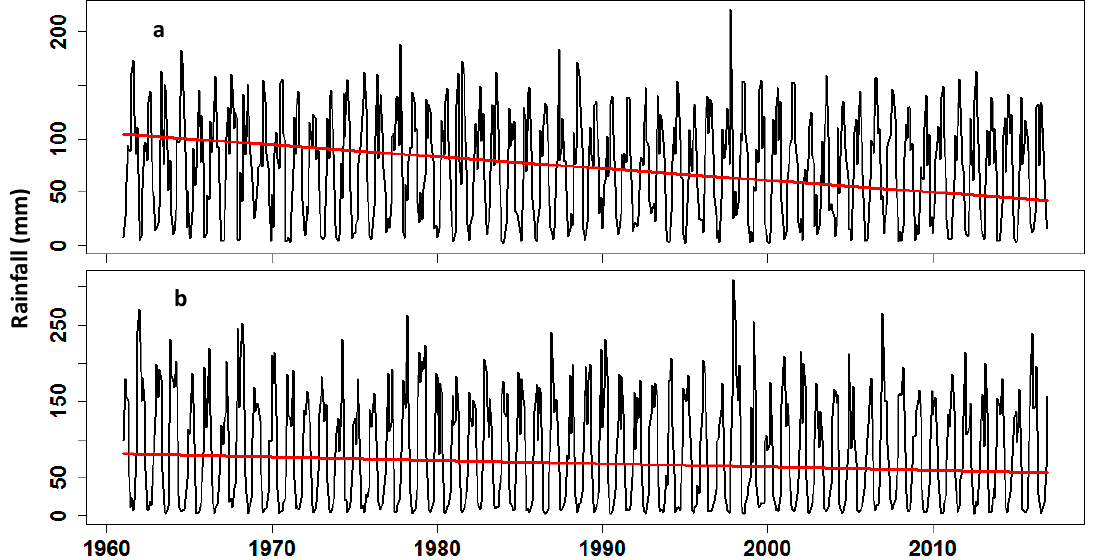
Figure 20. Seasonal Kendall rainfall trend with Seasonal Sen’s slope for ( a ) Ethiopia and ( b ) Tanzania for 1961–2016. Ethiopia exhibited a significant decrease in rainfall of more than 11 mm/decade ( p = 0.007), but the decrease in Tanzania was not significant at p < 0.05 ( p = 0.098).